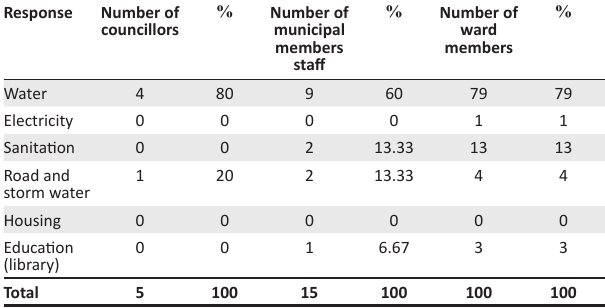
TABLE 6: Response from councillors on the most needed services.